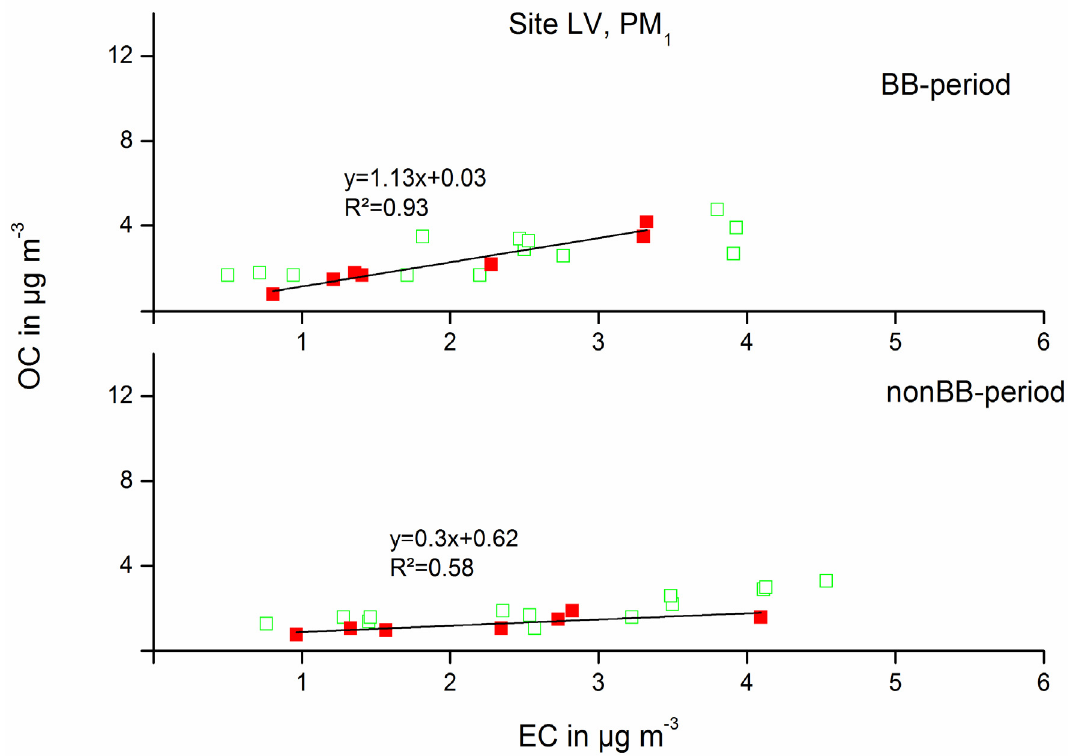
at site LV, PM p